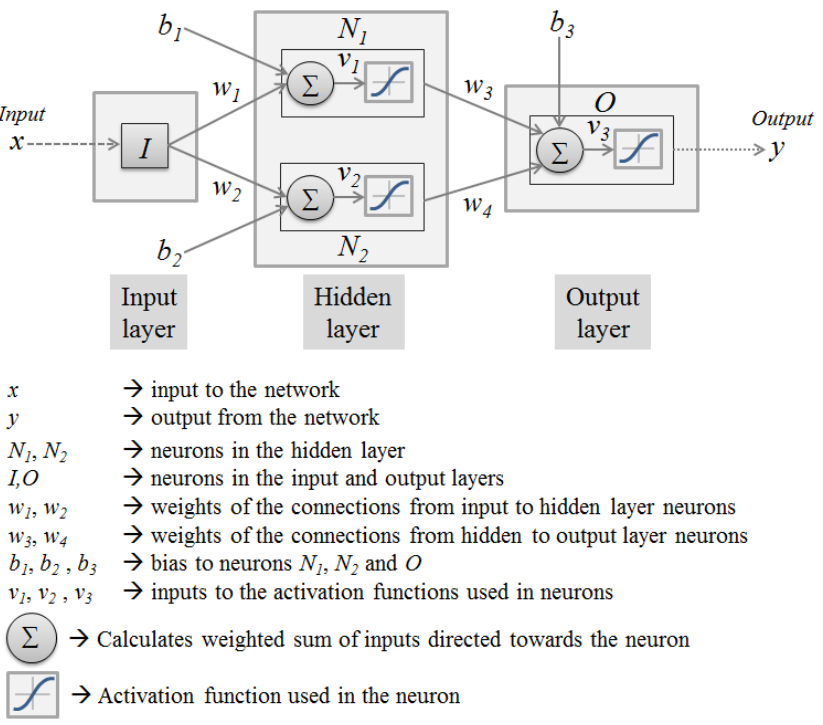
Figure 6. A simple artificial neural network model.